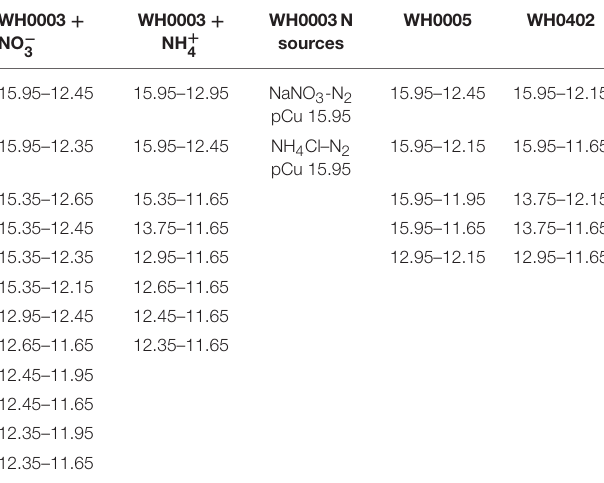
TABLE 3 | Summary of treatments (pCu or nitrogen source) between which statistically significant differences in observed mean growth rate were found according to Tukey’s